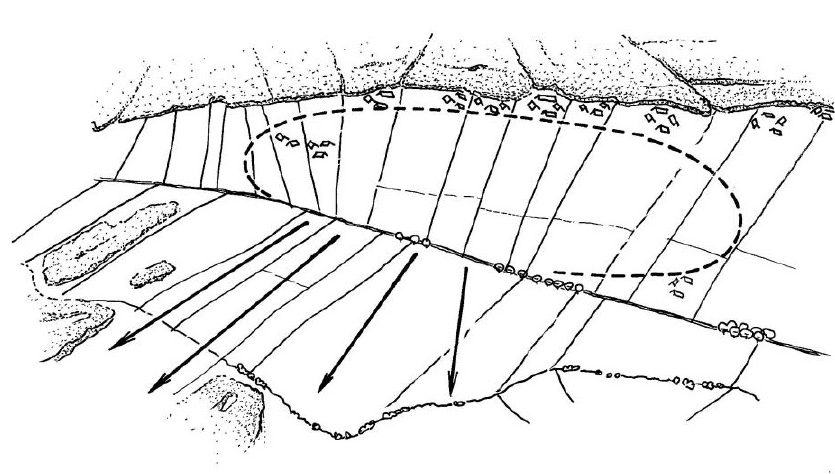
Figure 5. A synthetic sketch of the spatial composition for the sequence of views from route 1. The northern side of the route: a completely uncovered, slightly rising field with radial bounds, enclosed by the forest, and a few buildings; the southern side of the route: a panoramic view of the undulating terrain with irregular fields and distant